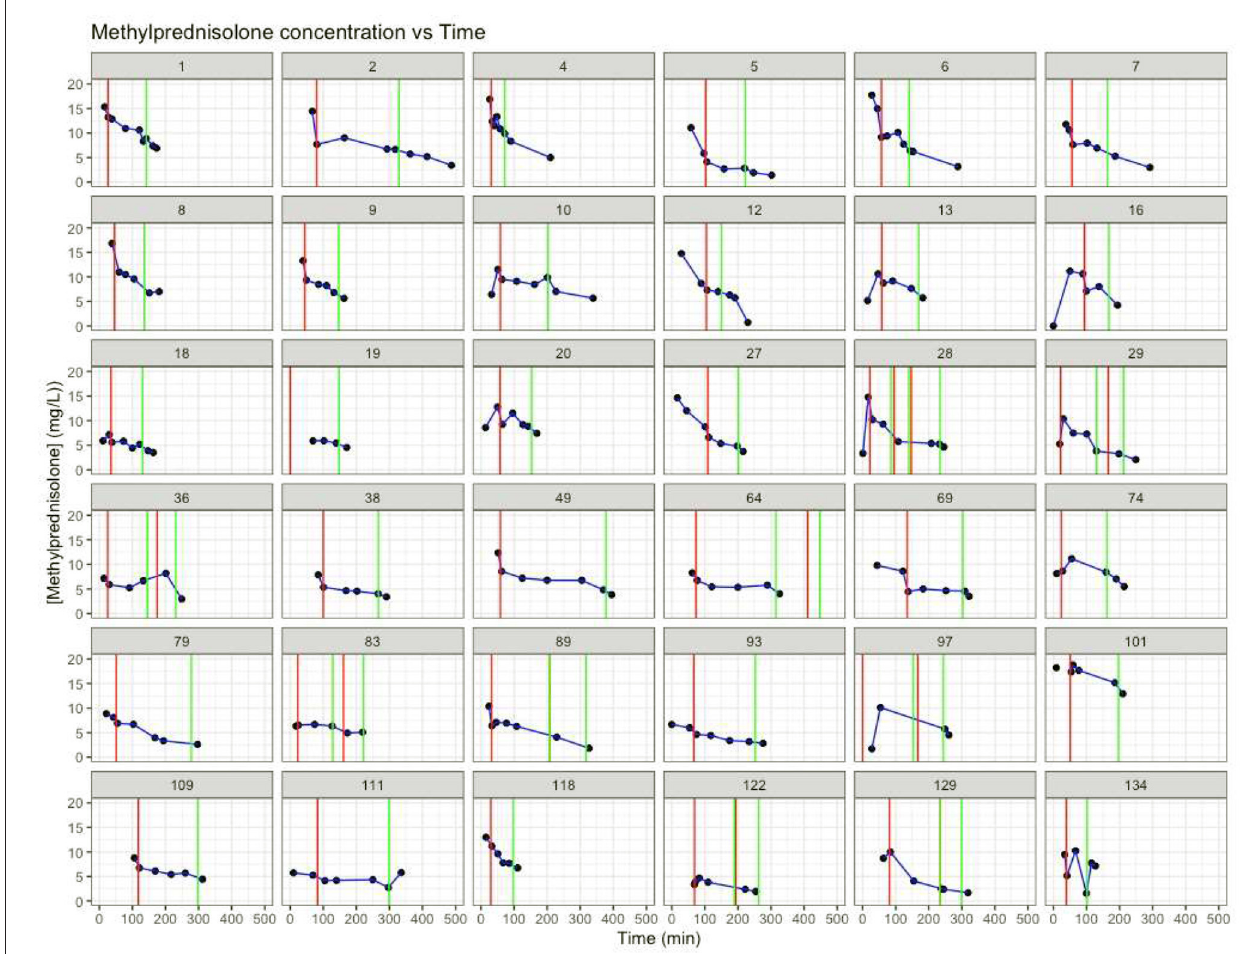
FIGURE 1 | Individual MP concentration (mg/L) vs. time (min). Red vertical lines: time start cardiopulmonary bypass. Green vertical lines: time stop cardiopulmonary bypass. T = 0: time of methylprednisolone